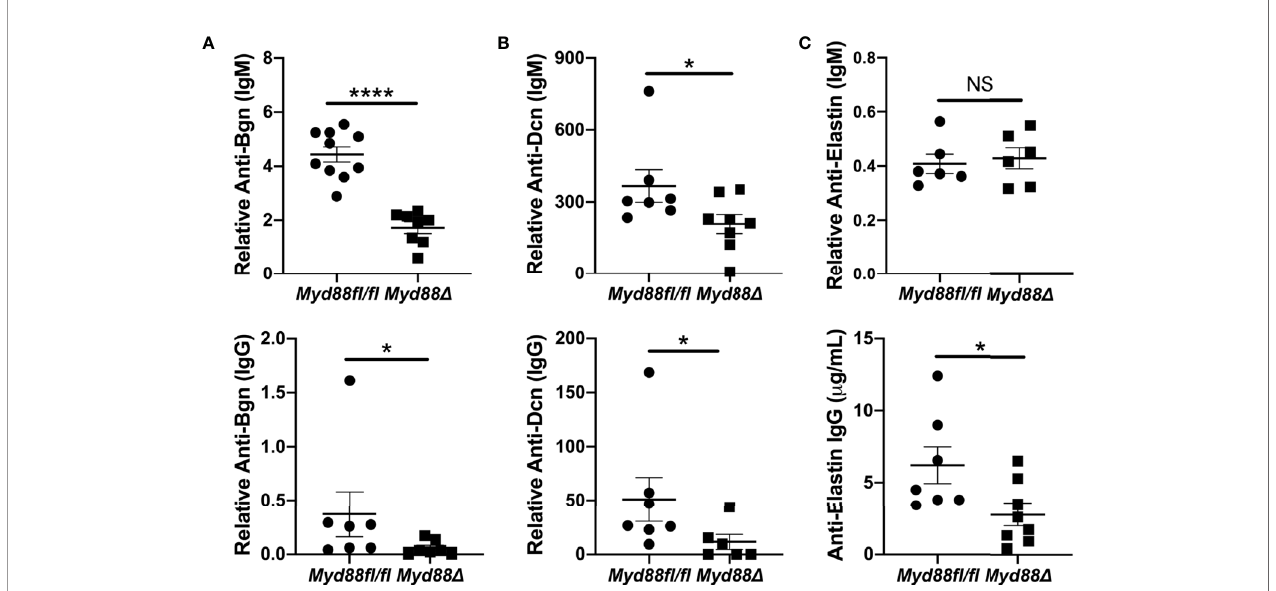
FIGURE 7 | Anti-Bgn, -Dcn and -Eln autoantibodies are elevated in pSS in a Myd88-dependent manner. Sera were harvested from NOD.B10 Myd88 fl / fl and NOD.B10 Myd88 D mice (n = at least 7 each) and ELISAs were performed for IgM and IgG autoantibodies directed against (A) Bgn, (B) Dcn and (C) Eln. Horizontal lines represent the mean and SEM, (NS, non-signi fi cant; *p < 0.05, ****p <